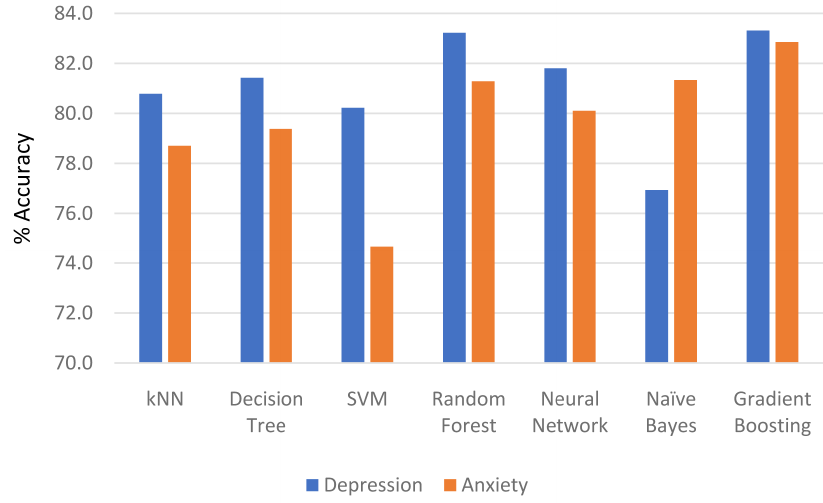
Figure 1. Percentage of ML models accuracy by depression and anxiety